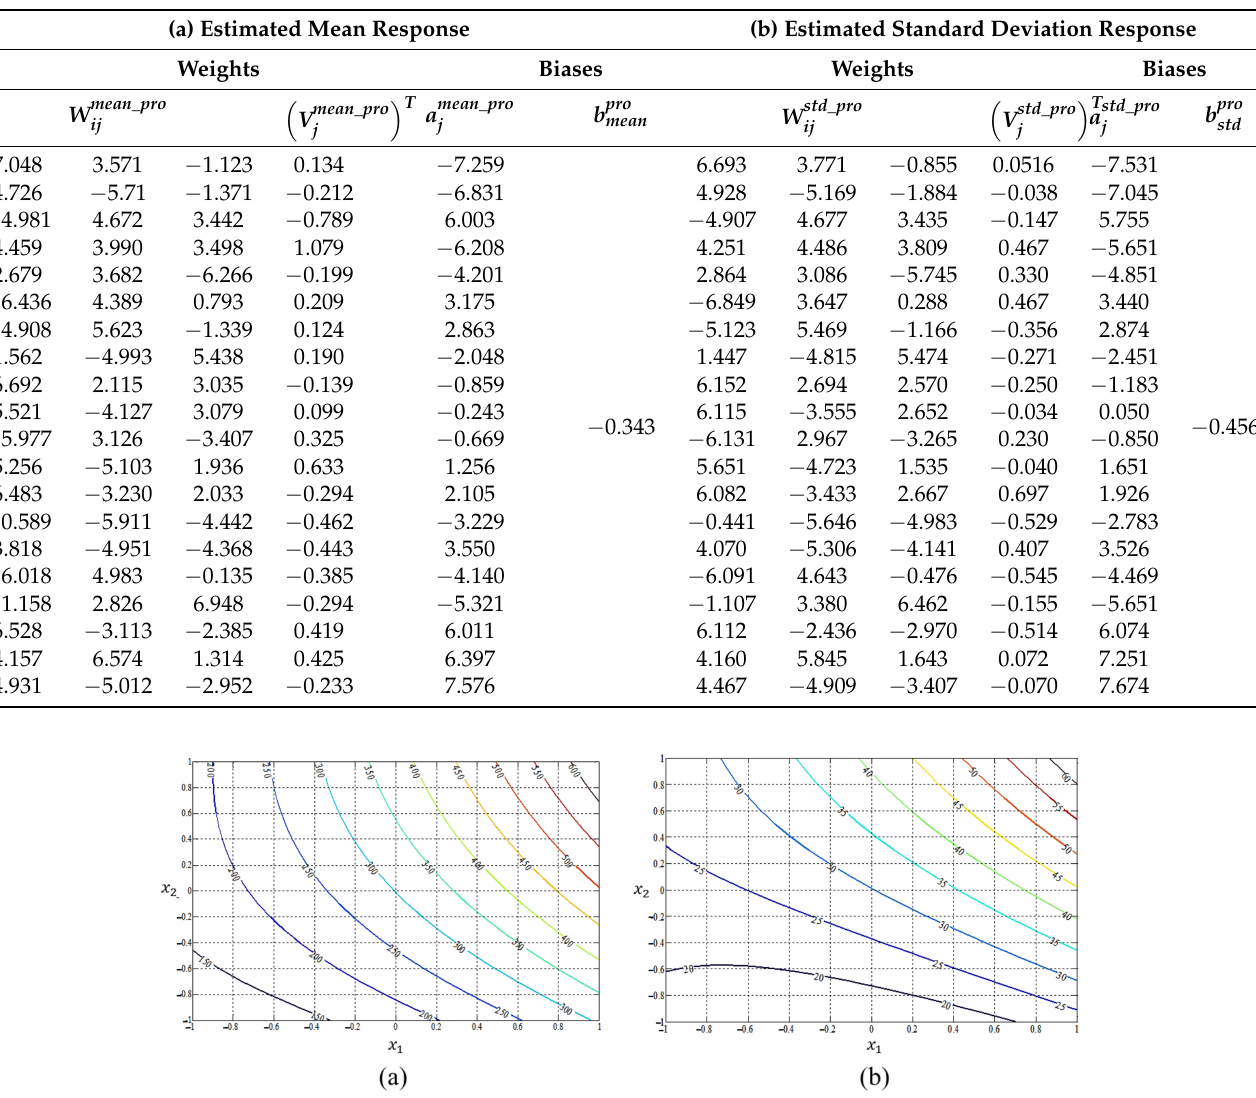
Table 4. Weight and bias values by using the NN-based DR estimation method.